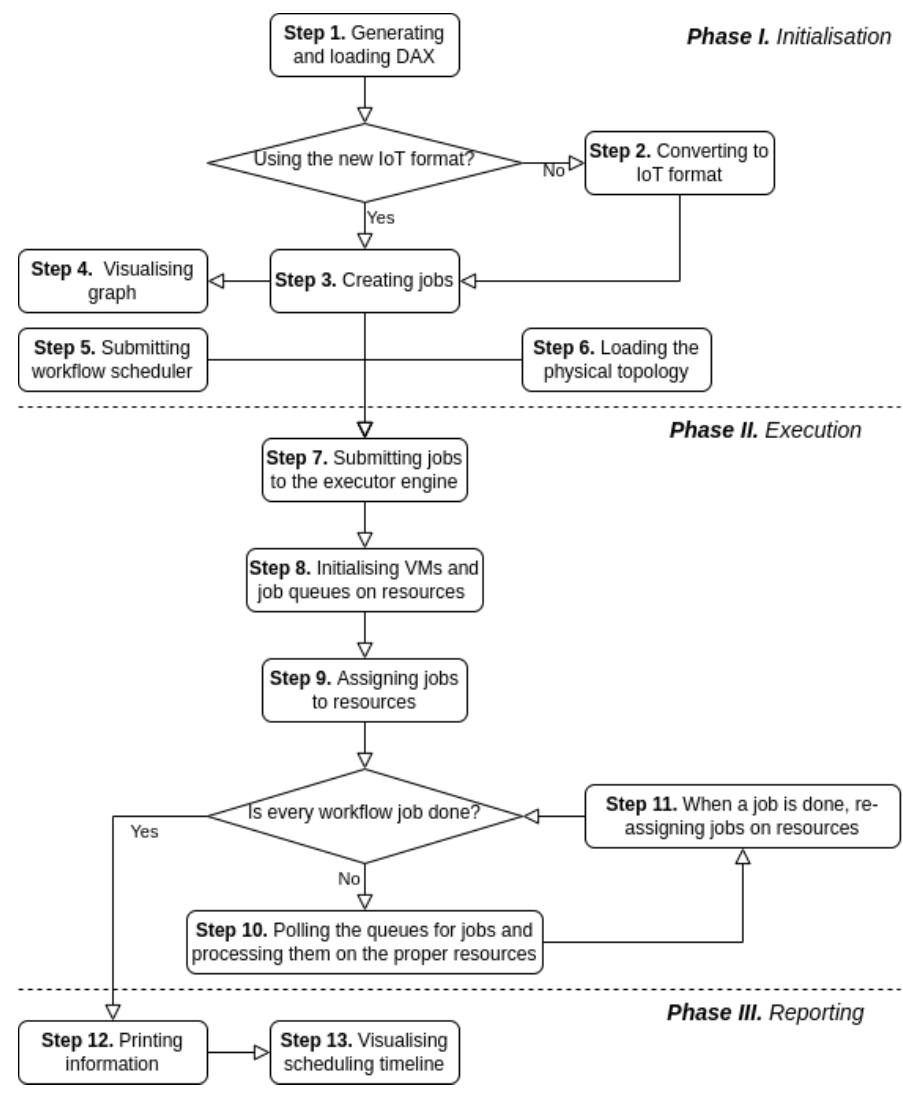
Figure 2. Flow chart of the extended simulator towards IoT workflow